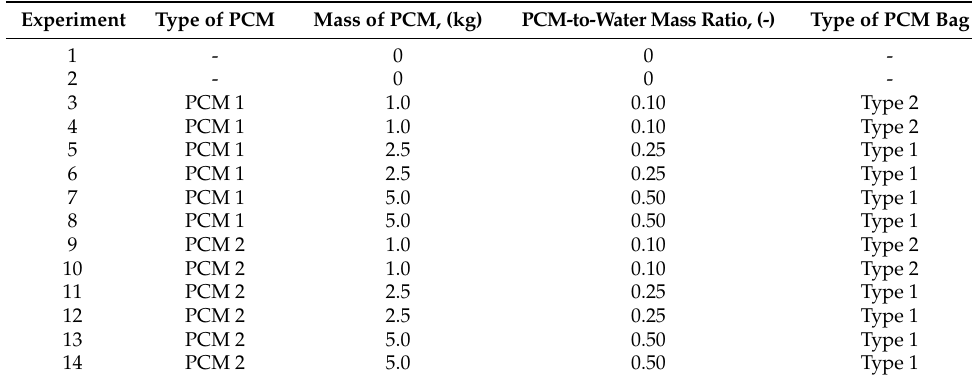
Figure 3. Electric-heater power as a function of time. Table 2. Experimental conditions.